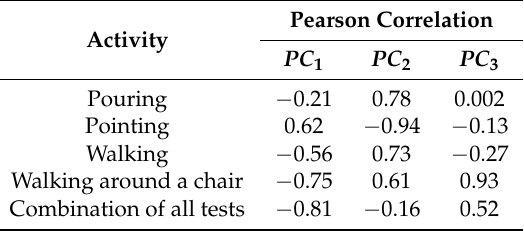
Figure 10. Combination of pouring, pointing, walking, and walking around a chair from Sensor 2 vs. 3. Table 4. Correlation between analysis results from four tests combination and H&Y score from Sensor 2 vs.